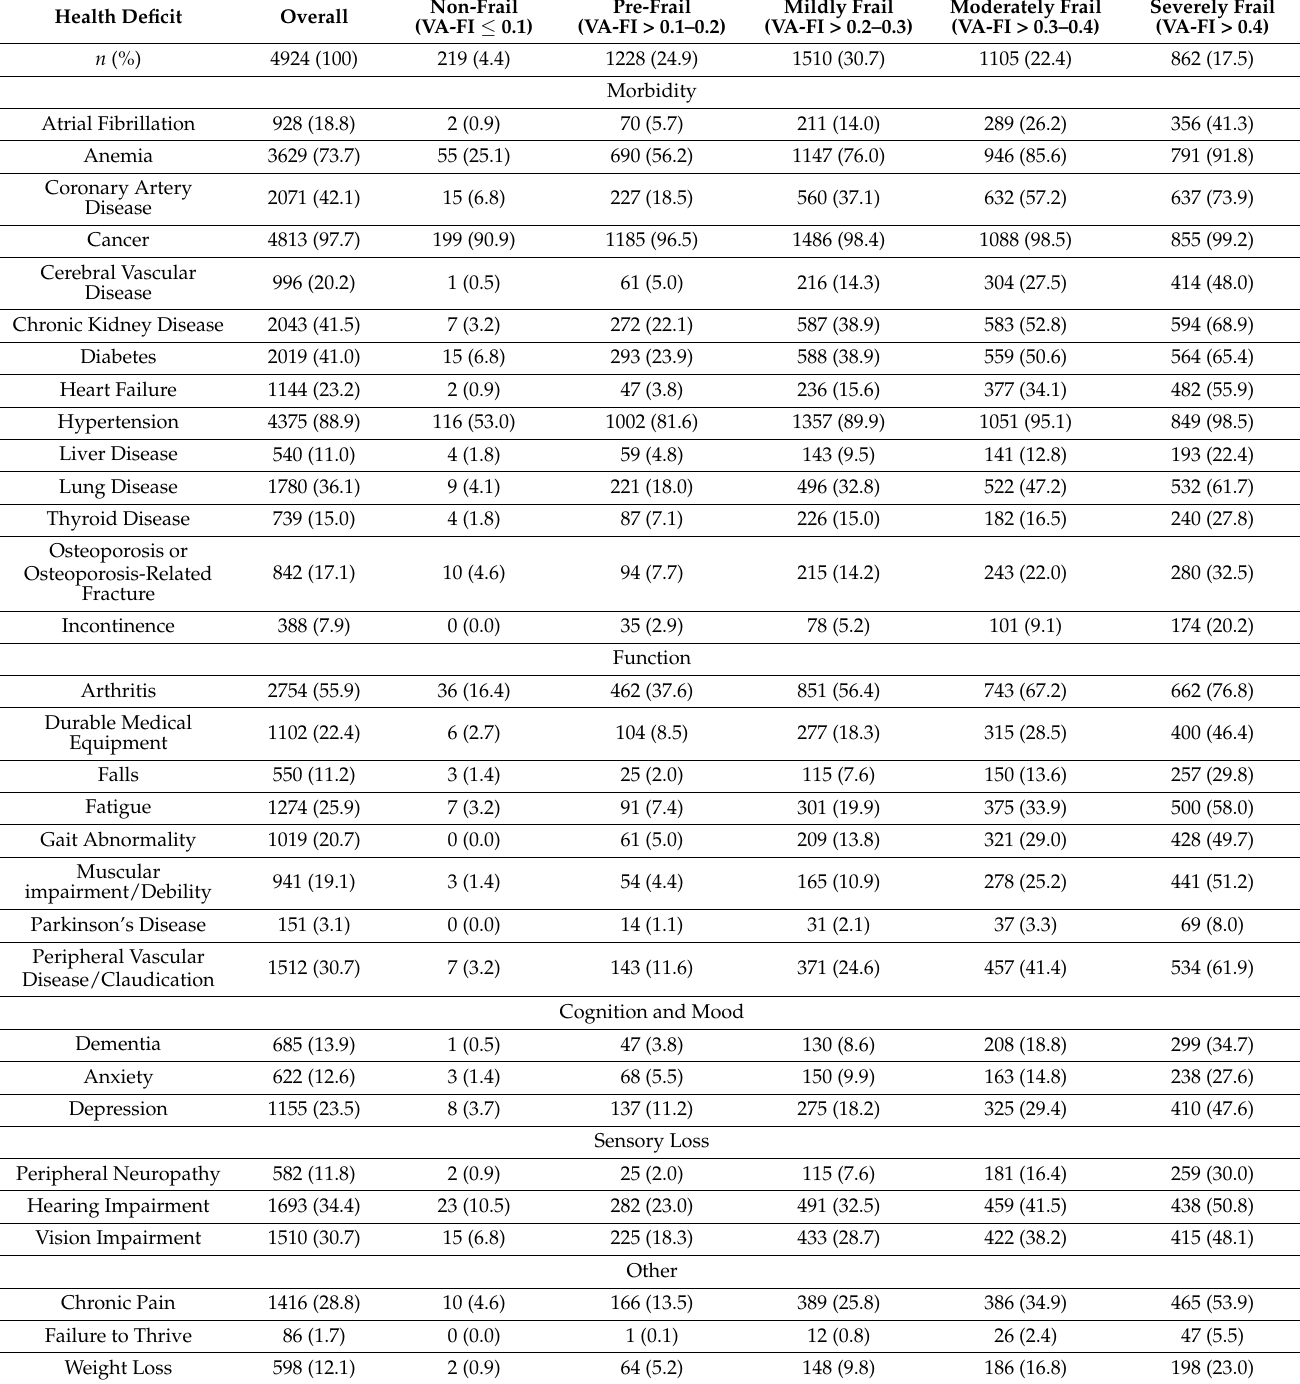
Table 2. Prevalence of VA-FI-10 health deficits for 4924 veterans with MM overall and by VA-FI